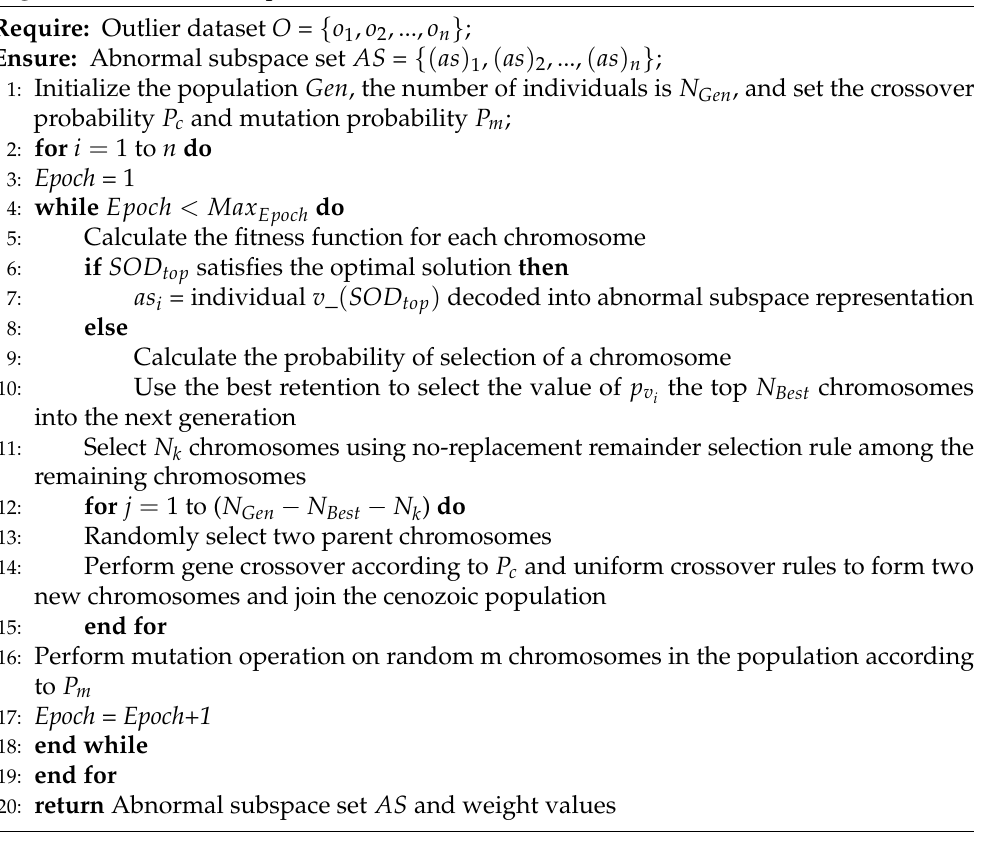
Algorithm 1 Search Subspace Process